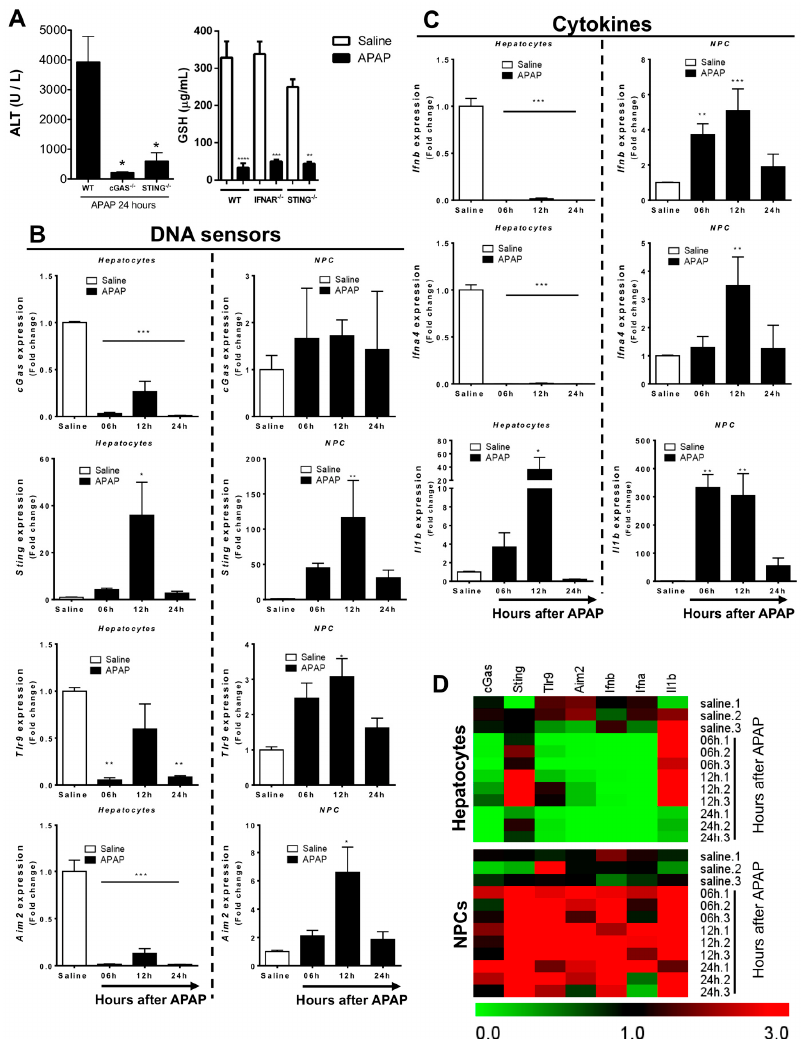
Figure 4. Evaluation of DNA sensor expression in different hepatic populations during APAP injury. ( A ) Absence of DNA sensing pathways cGAS, IFNAR and stimulator of IFN gene (STING) completely protected mice against APAP ‐ induced liver injury, but with no detectable changes in GSH levels during APAP challenge. ( B ) Gene expression of different DNA sensors and ( C ) cytokines in NPCs and hepatocytes cells after hepatic injury induction; the relative expression was done using the control (saline) population of each group as a reference. ( D ) Heatmap showing variations in gene expression at different times after induction of hepatic injury; green = decreased expression; black = no variation; red = increased expression. (Mean ± SEM; n = 4); * p ≤ 0.05, ** p ≤ 0.01, *** p ≤ 0.001 and **** p ≤ 0.0001. The graphs represent the mean expression of selected genes relative to saline hepatocytes ( ΔΔ CT).